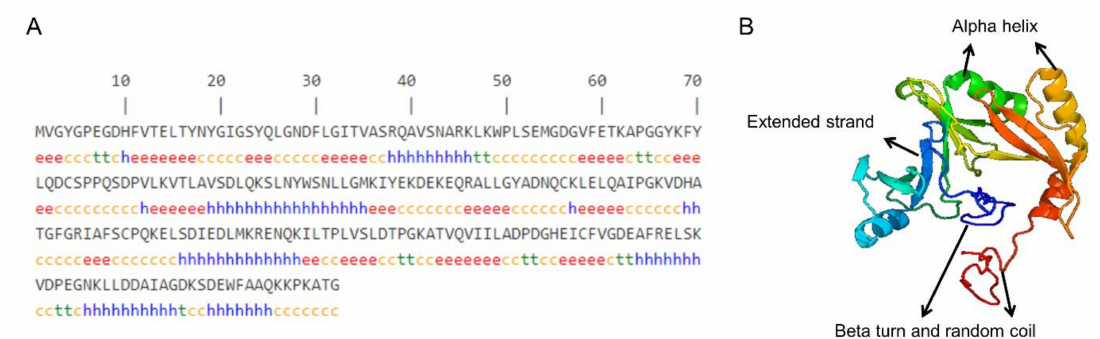
Figure 2. Sequence alignment for predicted and cloned sheep GLOD4 CDS.